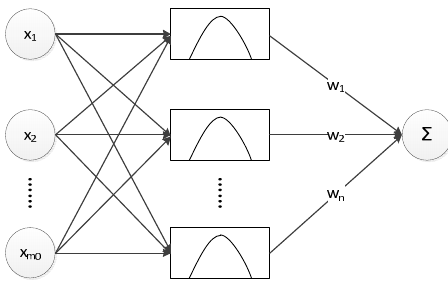
Figure 1. Schematic illustration of radial basis function (RBF)-artificial neural network (ANN).